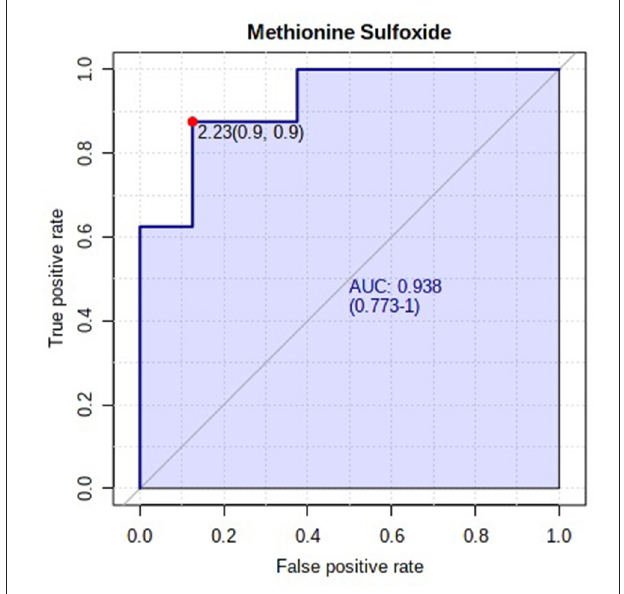
FIGURE 8 | Biomarker analysis of plasma carboxylic acid-metabolome. ROC curve analysis of methionine sulfoxide.